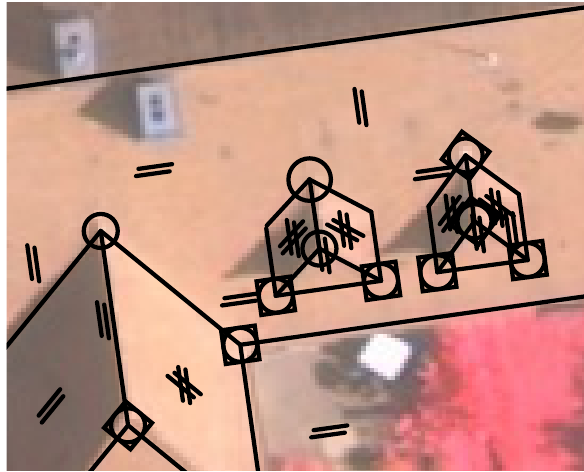
Figure 7. Display detail of Figure 6 showing the building’s dor- mers which constitute subtasks to be solved.